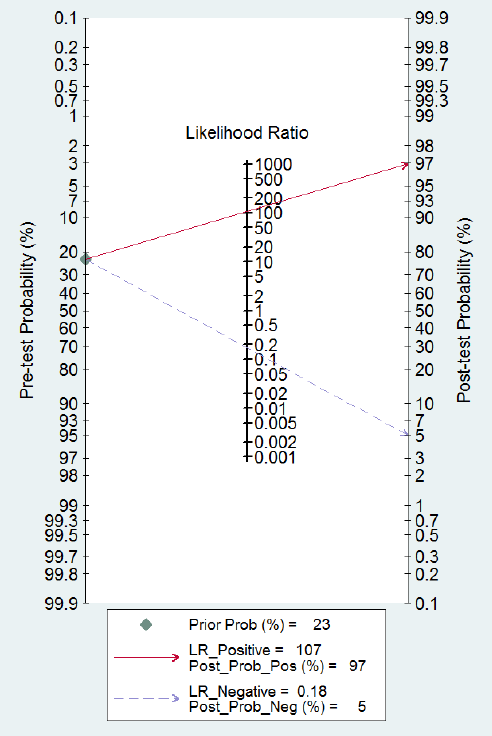
Figure 6. Fagan nomogram for two-dimensional transvaginal ultrasonography. It can be observed how the test changes the pre-test probability depending on a positive or negative